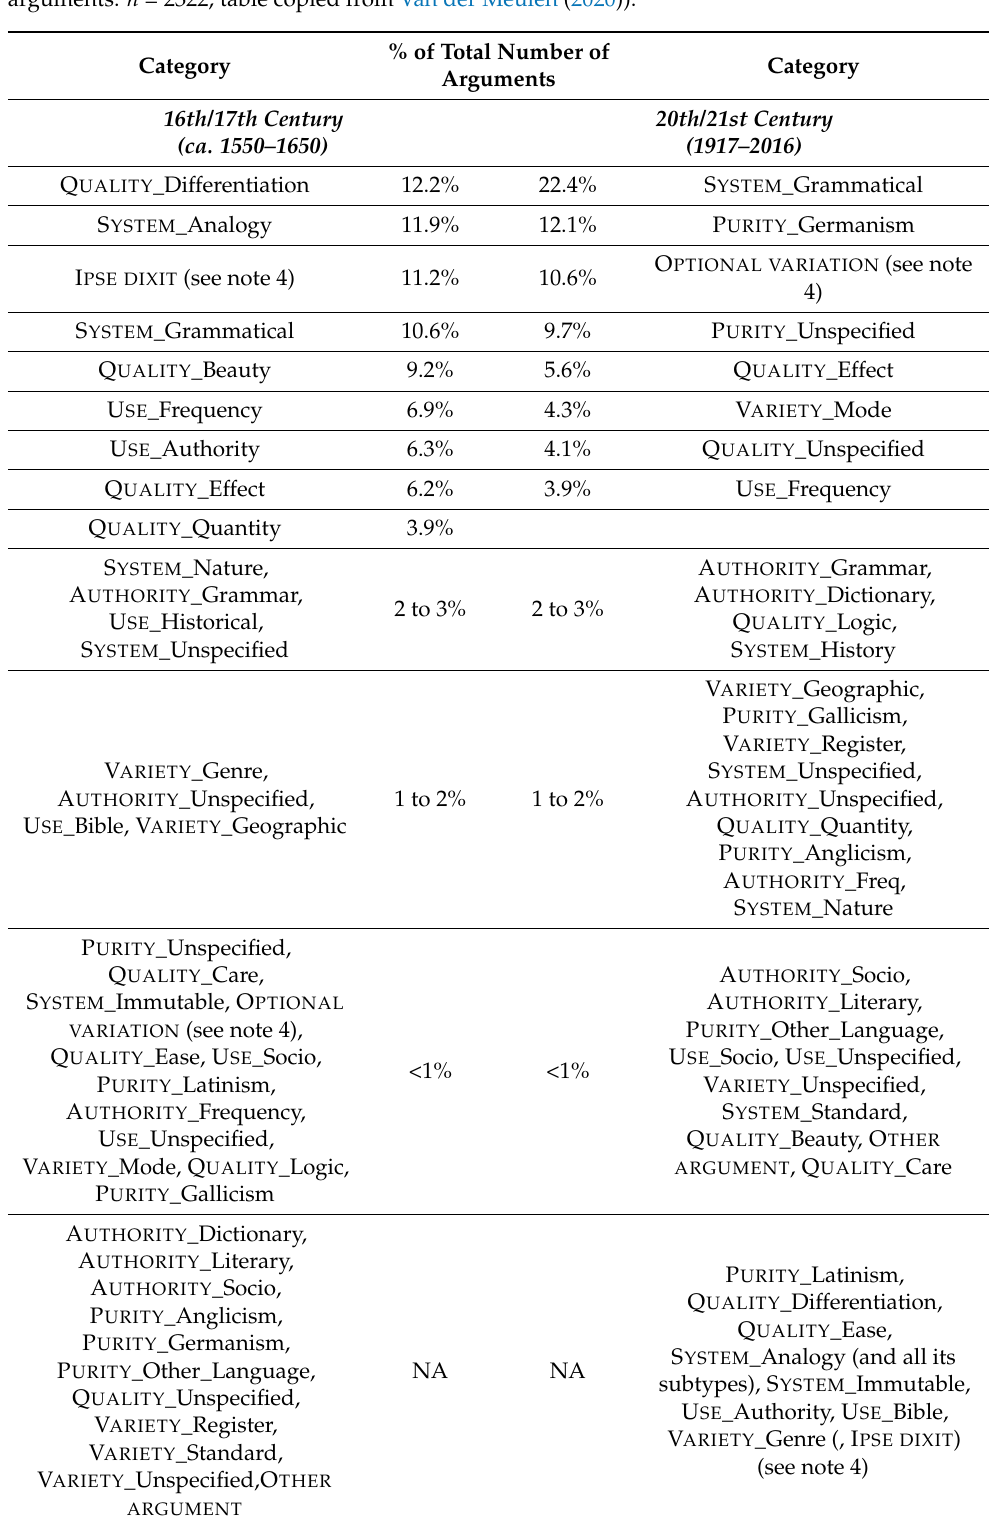
Table 5. Percentages of lower-level categories of arguments used in normative works on Standard Dutch from ca. 1550 to 1650 (total number of arguments: n = 1011) versus 1917–2016 (total number of arguments: n = 2322; table copied from Van der Meulen